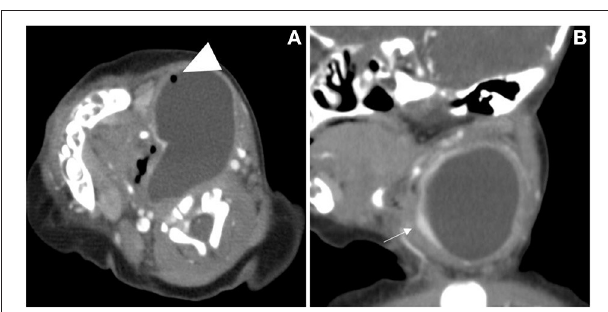
FIGURE 4 | The cervical CT images of a 7-day-old girl. A cystic mass without septum was demonstrated in the left neck, small air bubbles can be seen inside (arrowhead), the wall of the cyst was thin and iso attenuation, and the border was well defined. The cystic mass, shaping as a “comma,” extended laterally into the retropharyngeal space and the airway was deviated (A) . The left thyroid gland lobe was involved and pushed anteriorly on sagittal view ( B , arrow).